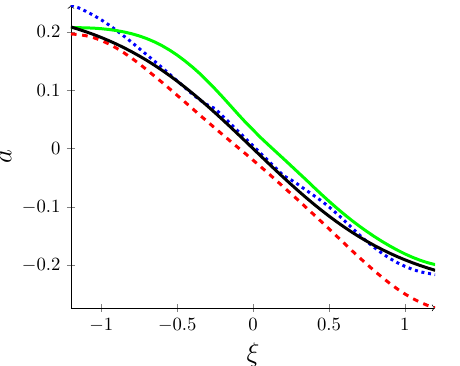
Figure 10 . The bias function a as a function of rapidity (cid:24) , evaluated at (cid:28) = 2, for the cases ( w ; w (cid:0) ) = (0 : 075 ; 0 : 35) (green line), ( w + (0 : 1 ; 0 : 25) (blue dotted line). The black line corresponds to the (cid:12)tting function f ( (cid:24) ) = (cid:0) tanh( (cid:24) ) = 4.